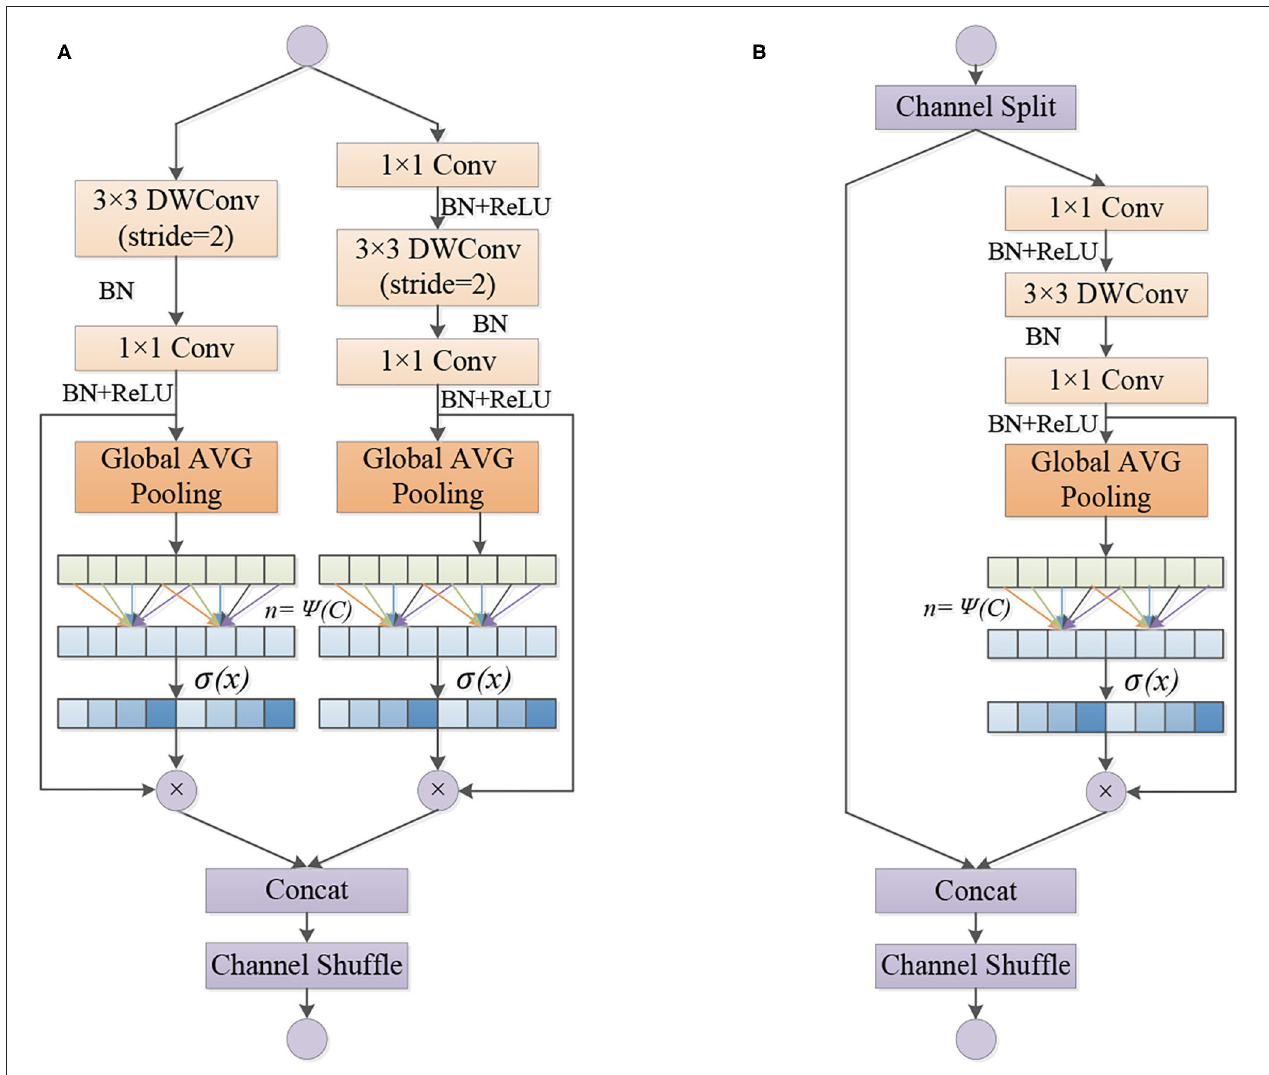
FIGURE 4 | Detailed structure of the ECA-SNet Unit. (A) Unit 1. (B) Unit 2.